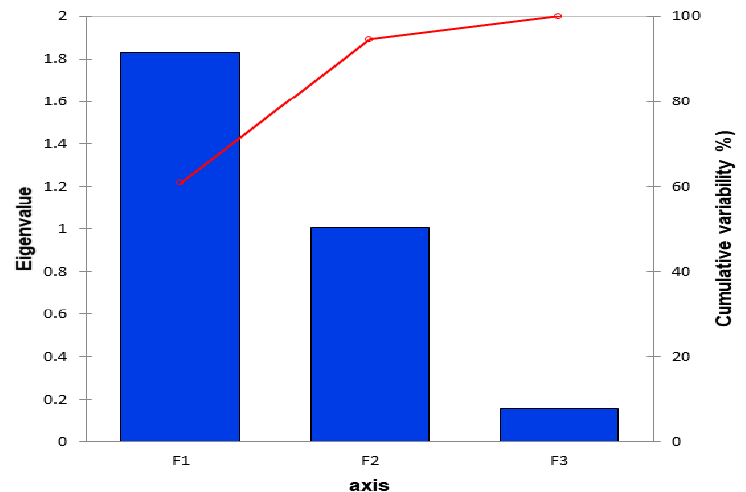
Figure 3. The scree plot indicating the number of significant factors explaining the variations. F1–3: factors 1–3.